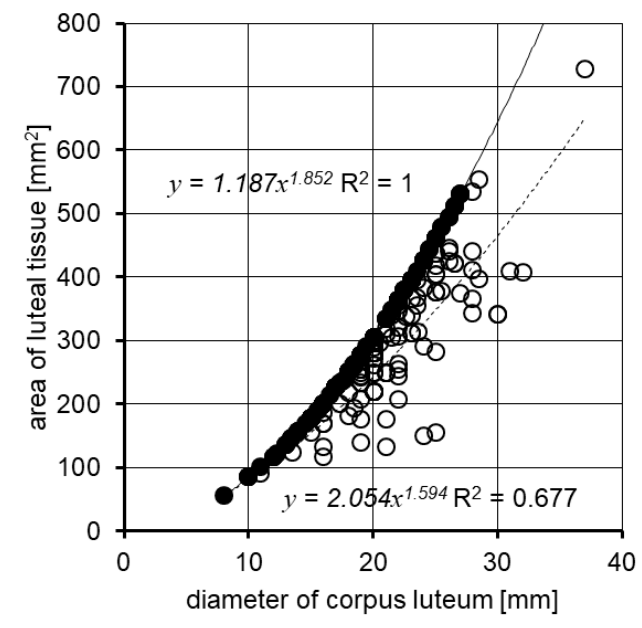
Figure 1. A comparison of area of luteal tissue in cavitary and compact CLs. ● area of luteal tissue in the compact CL; ○ area of luteal tissue in cavitary CLs. CL: corpus luteum.